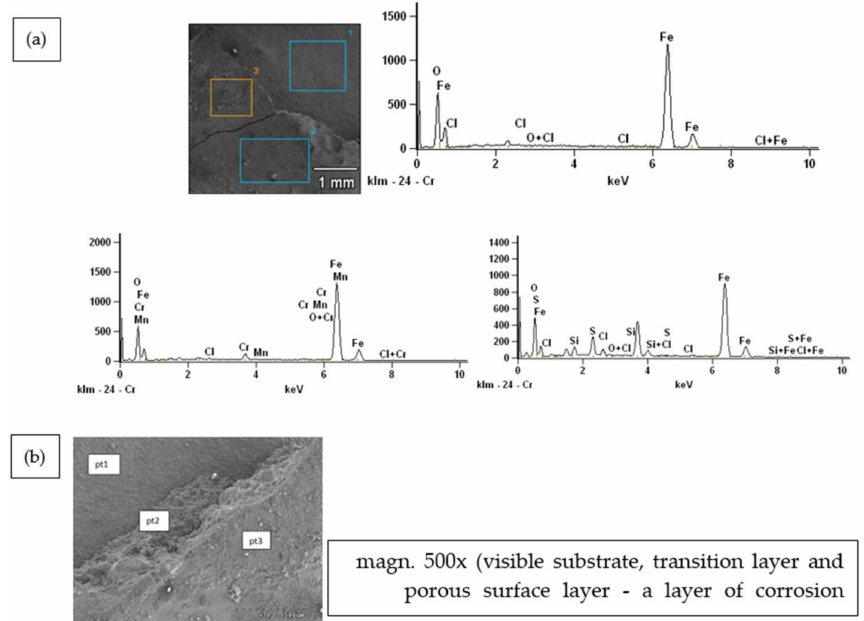
Figure 16. ( a ) The chemical composition of the surface of the St41K boiler steel in the planes pt1, pt2 and pt3 on the microscopic photo; ( b ) microscopic photo (SEM) of the surface of the St41K boiler steel.